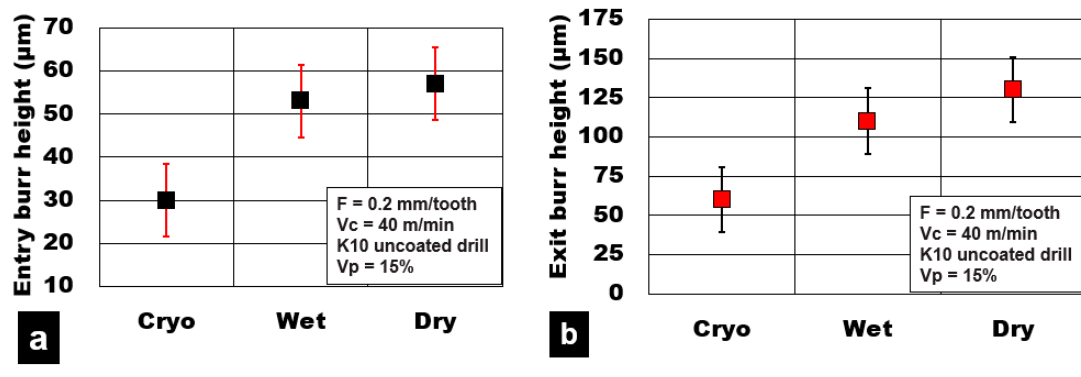
Figure 9. Effect of cooling medium on hole burr height during plunge drilling of AZ31-alumina syntactic foam. ( a ) Entry burr height; ( b ) Exit burr height.